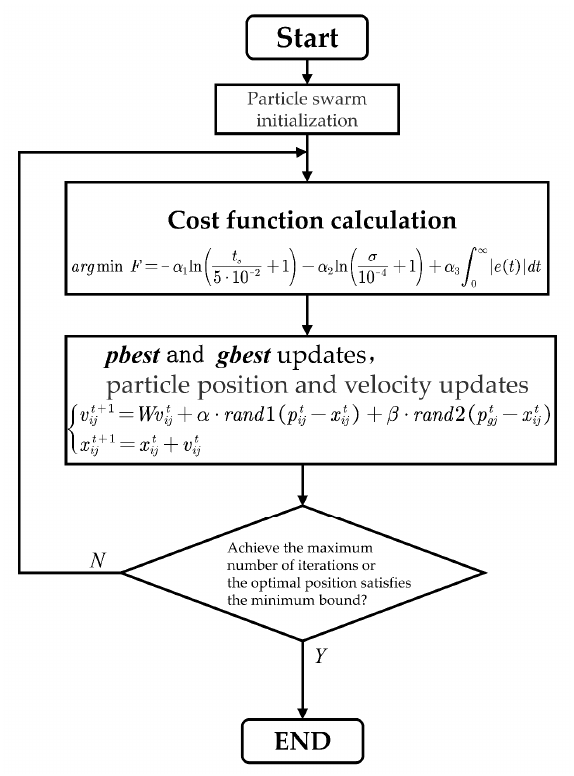
Figure 5. Flow chart of PSO parameter optimization.